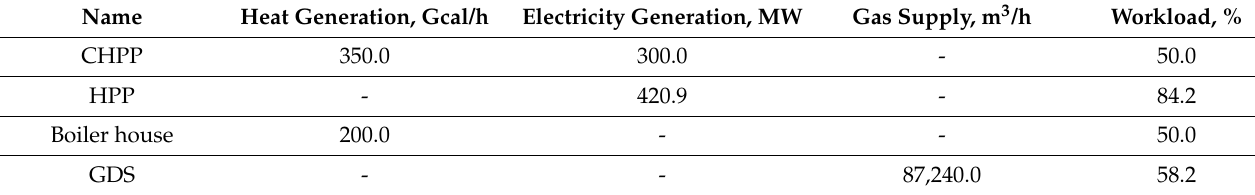
Table 2. Calculation results for prosumers.